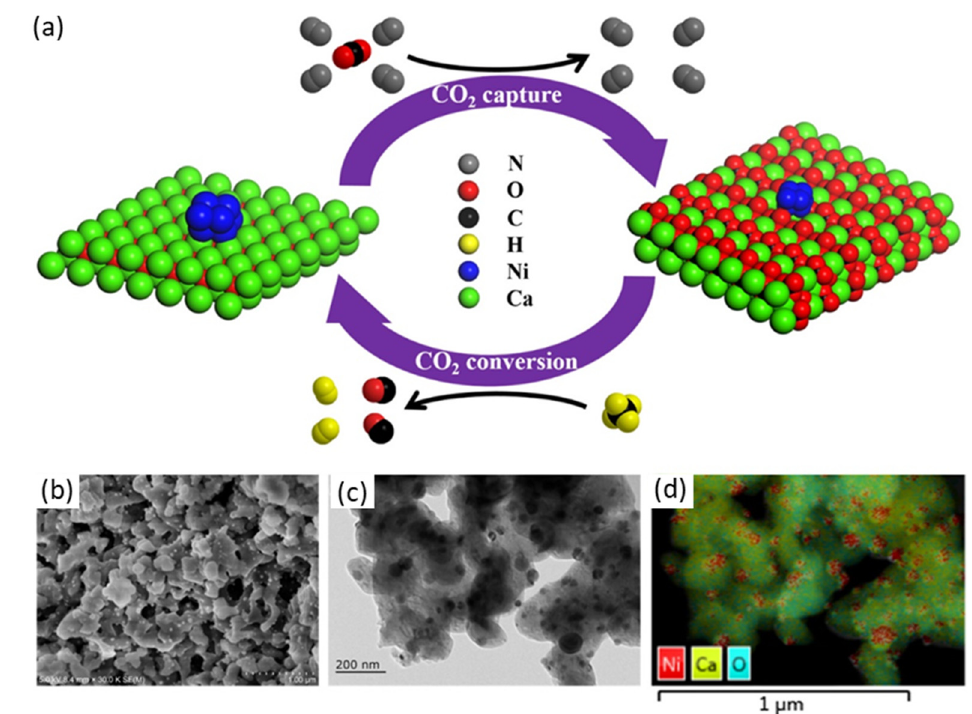
Figure 15. Illustration of the combined calcium looping and dry reforming process. ( a ) Process schematic, ( b ) particle shape and ( c , d ) structure and element map of the CaO-Ni multifunctional material (reduced CaO/Ni) [83].